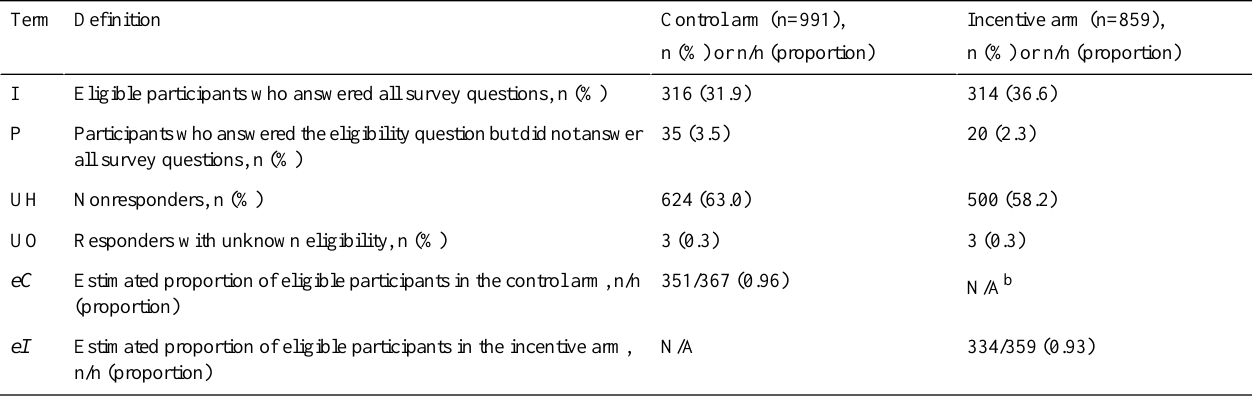
Table 1. Response rate calculation values using response rate three (RR3) a .